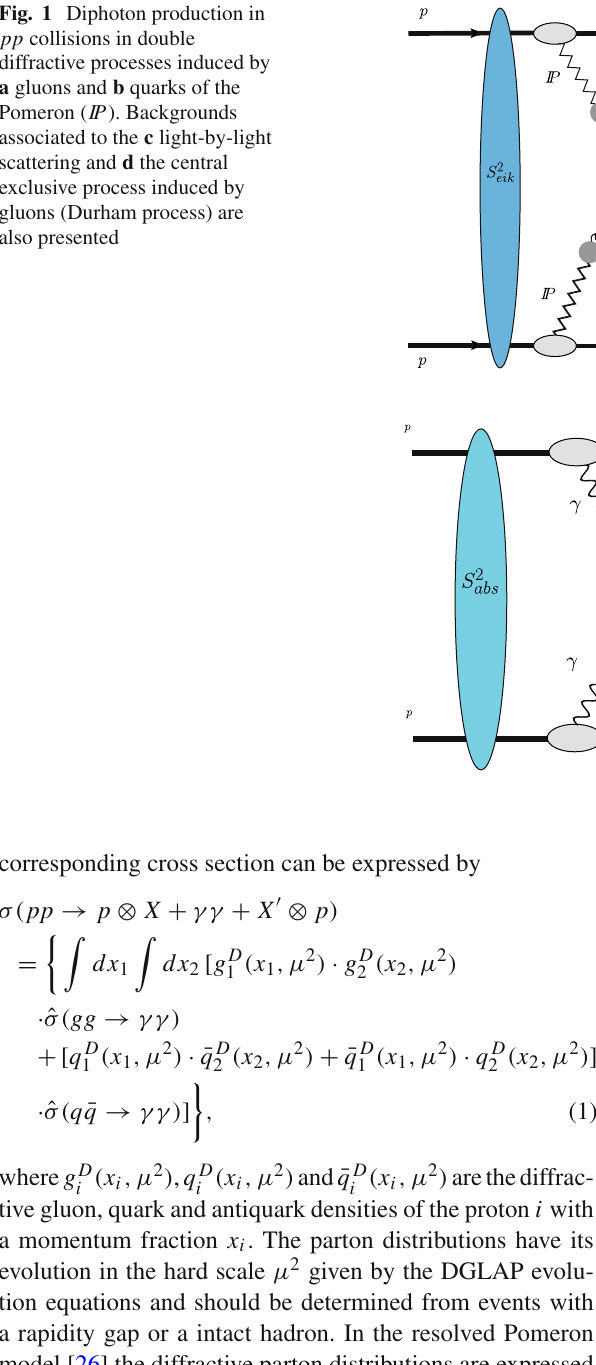
Fig. 1 Diphoton production in pp collisions in double diffractive processes induced by a gluons and b quarks of the Pomeron ( IP ). Backgrounds associated to the c light-by-light scattering and d the central exclusive process induced by gluons (Durham process) are also